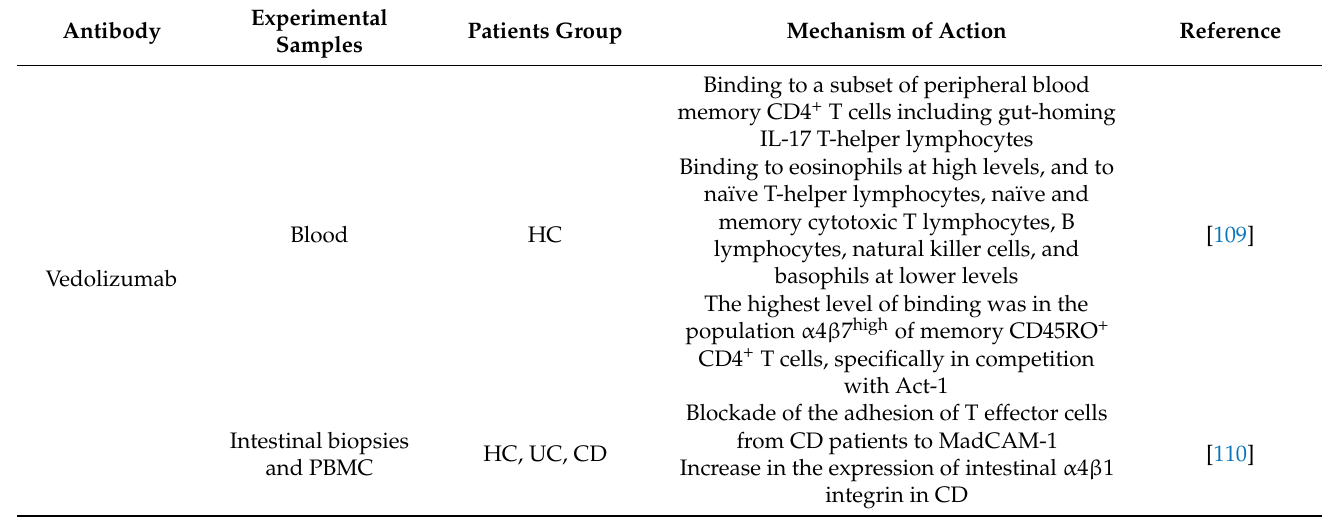
Table 4. Summary of studies evaluating the mechanistic effects of anti-integrins antibodies in inflammatory bowel disease.